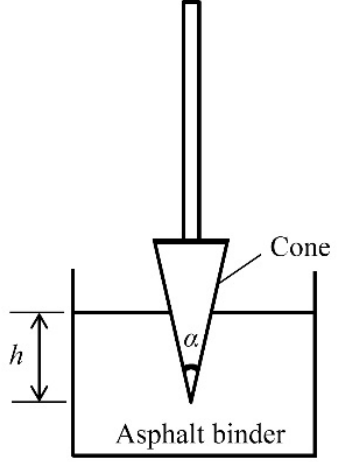
Figure 2. Sketch of the fall cone test.